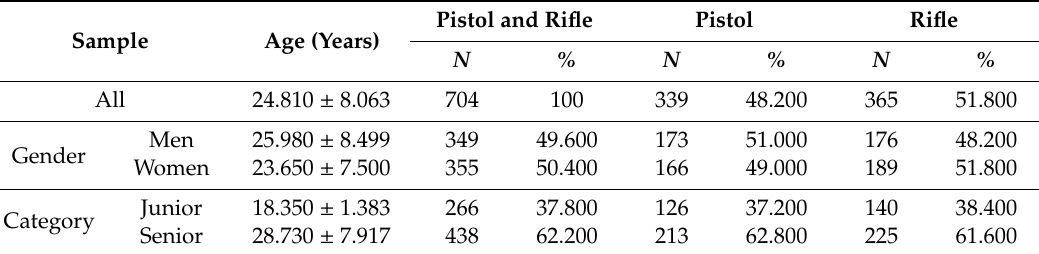
Table 1. Participants